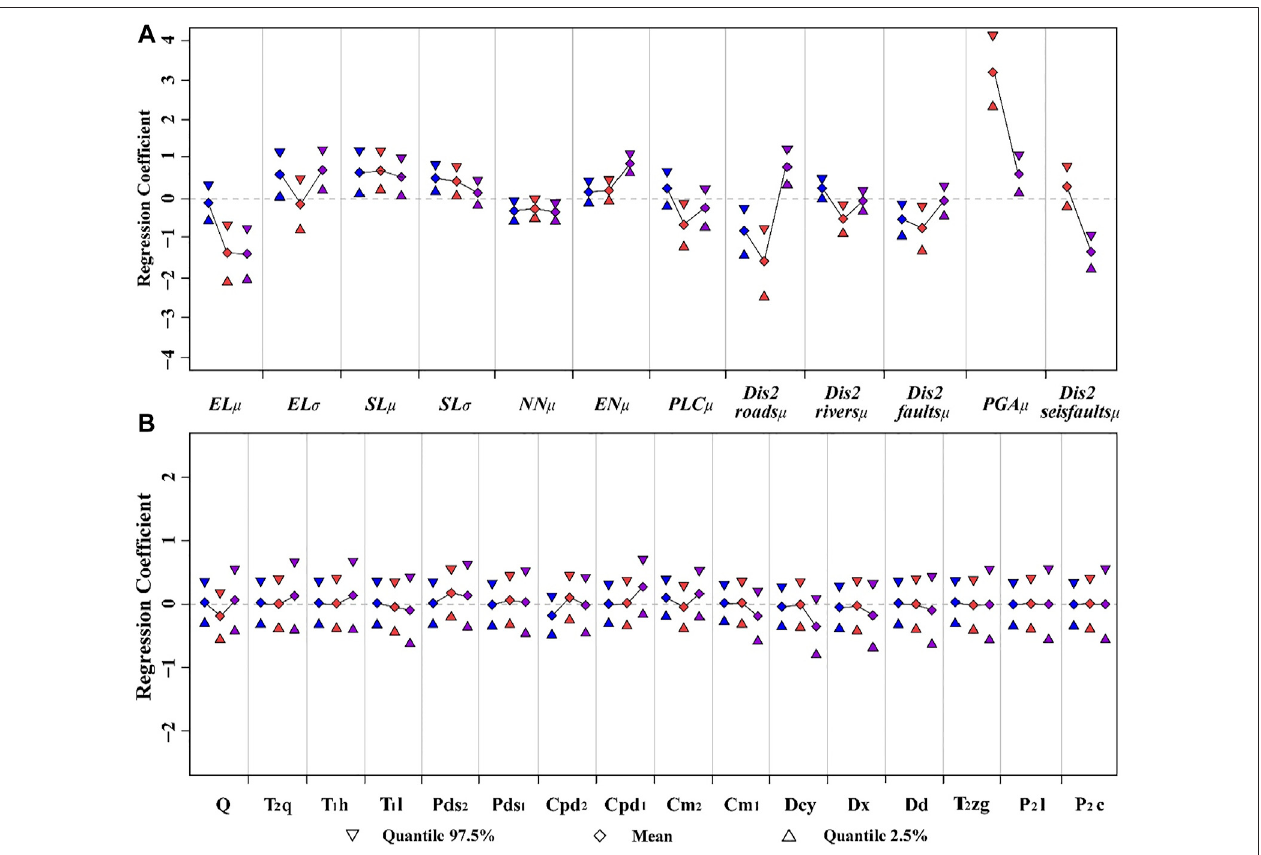
FIGURE 7 | Regression coef fi cients of (A) continuous covariates whose coef fi cients were signi fi cant in at least one of the three models and (B) lithology (Codes correspond to the strata in Tables 1 , 3 ) for each landslide inventory-based susceptibility model Mod1 (blue), Mod2 (red), and Mod3 (purple). A 95% credible interval is expressed as the difference between the quantiles of 97.5 and 2.5. The gray dash line corresponds to zero or no contribution to the